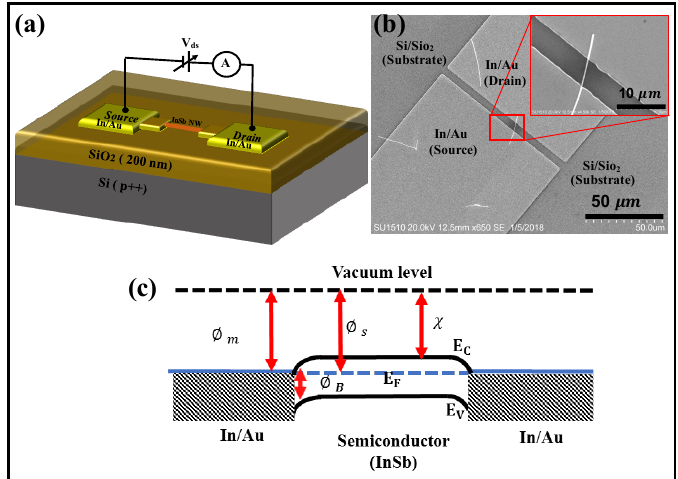
Figure 7. ( a ) A schematic of the two-terminal device showing the single NW with the In / Au source and drain contacts. ( b ) An SEM image of a single InSb NW contacted by In / Au contacts; inset shows an enlarged view of the channel that contained a single InSb NW. ( c ) A schematic of simplified energy band diagram of the metal-nanowire-metal contact in the absence of any applied bias.